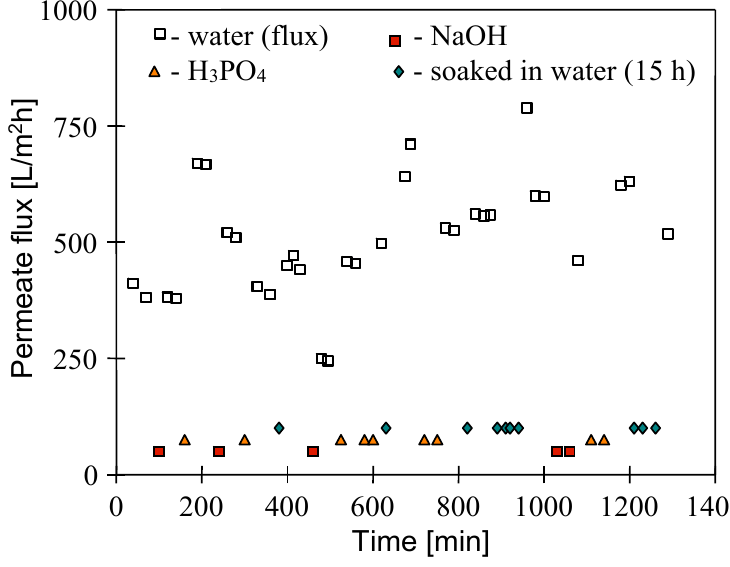
Figure 22. Variations in permeate flux during membrane cleaning after MF of oily wastewater #4.